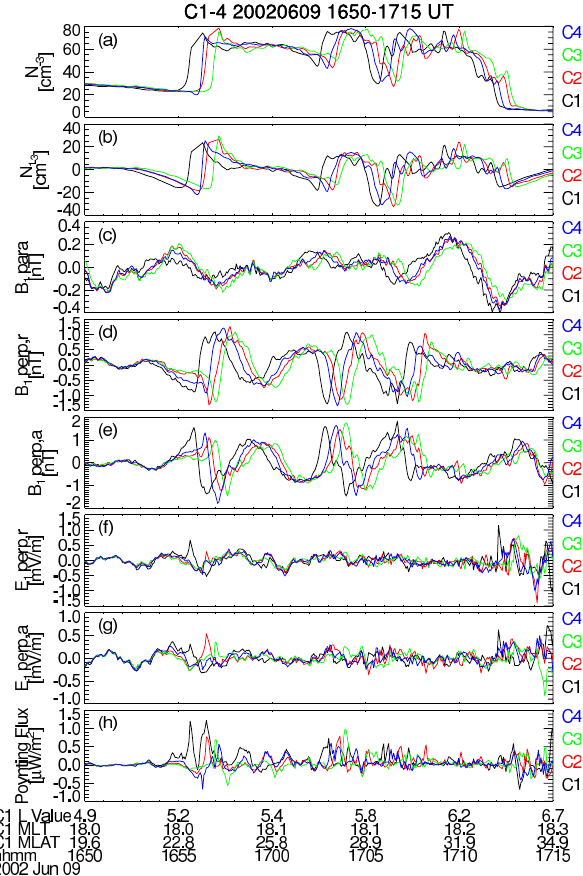
Fig. 10. Cluster data from all spacecraft during a plume crossing from 16:50 to 17:15UT on 9 June 2002. Each panel shows the same quantity as Fig.